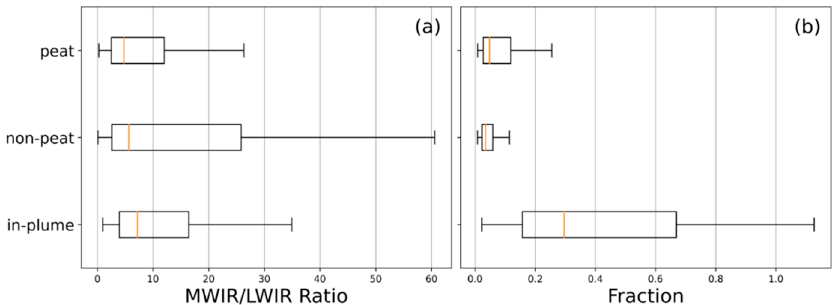
Figure 6. Spectral ratio ( a ) and subpixel active fire fraction ( b ) for AHI-detected active fire pixels contained in our matchup fires against all AHI-detected active fire pixels for September and October 2015 identified in the study region (latitude range: 10° N:10° S; longitude range: 100° E:120° E). Active fire pixels are separated into those burning on peatlands and on non-peatlands using the Global Forest Watch peat map shown in Figure 2. As with Figure 5, the boxplots in ( a , b ) follow standard conventions.